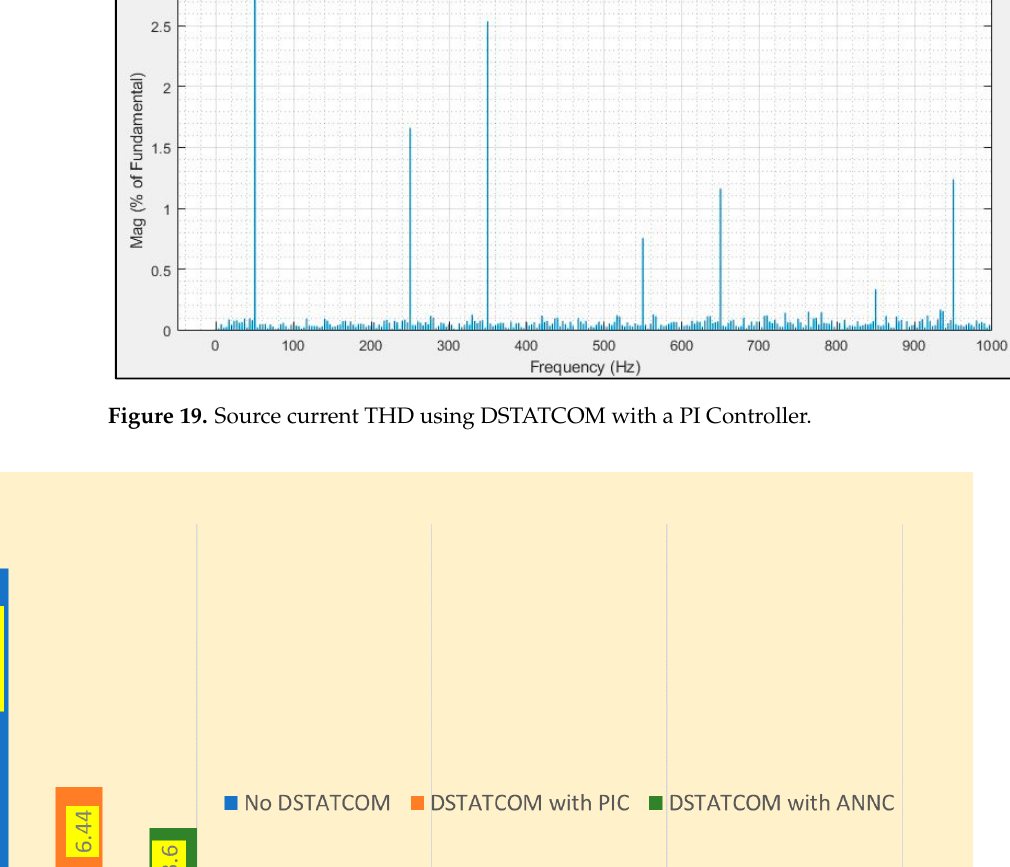
Figure 20. THD comparison with and without DSTATCOM.